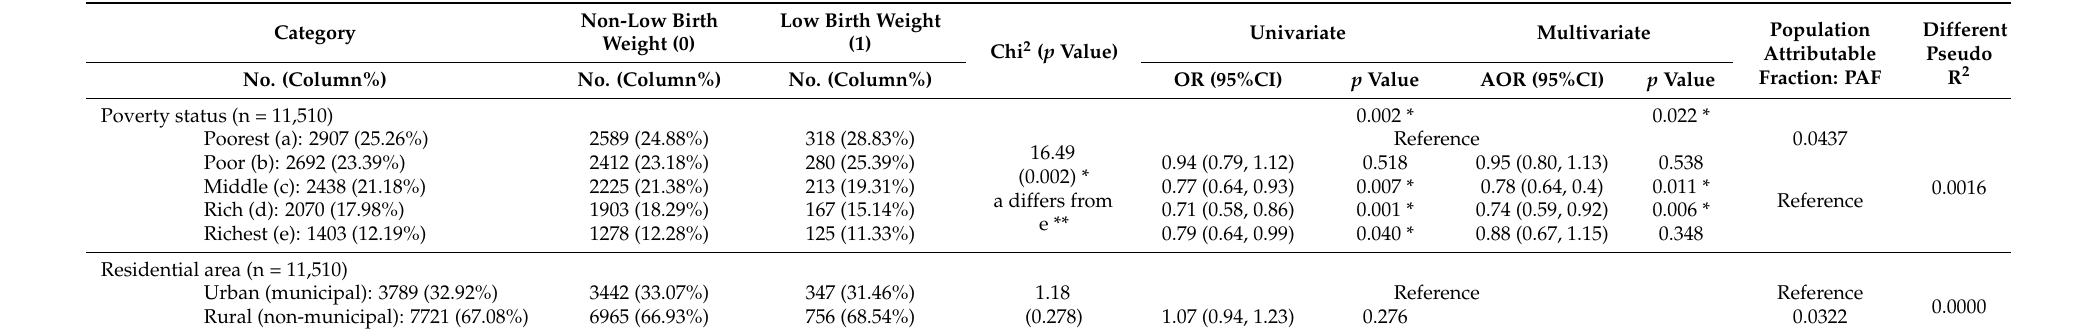
Table 3. The proportion of children born with low birth weight by socioeconomic status (SES), association between having low birth weight and socioeconomic status, and effect of each SES as illustrated by the PAF and different pseudo-R-squared